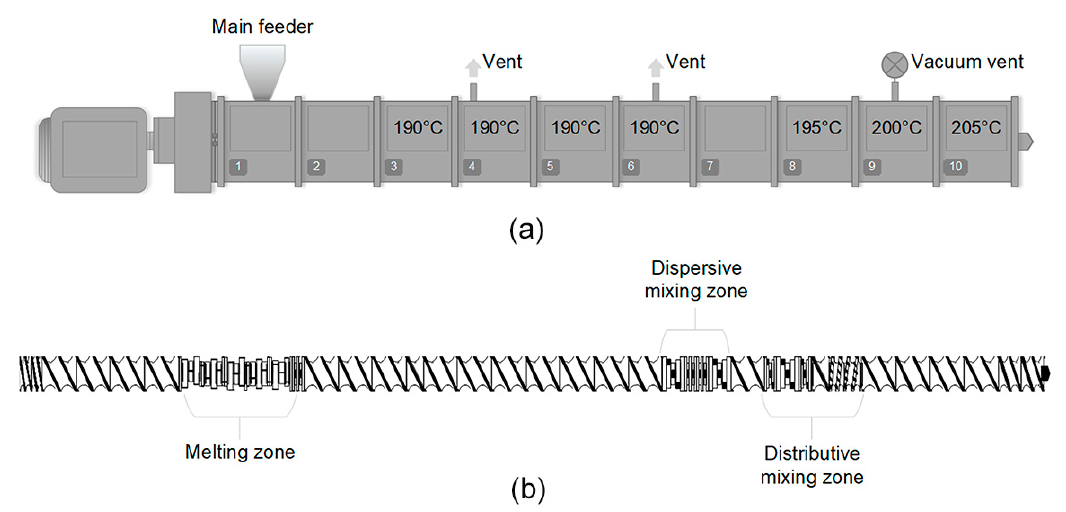
Figure 1. The used ( a ) twin-screw extruder profile and ( b ) screw-design in the recycling process .